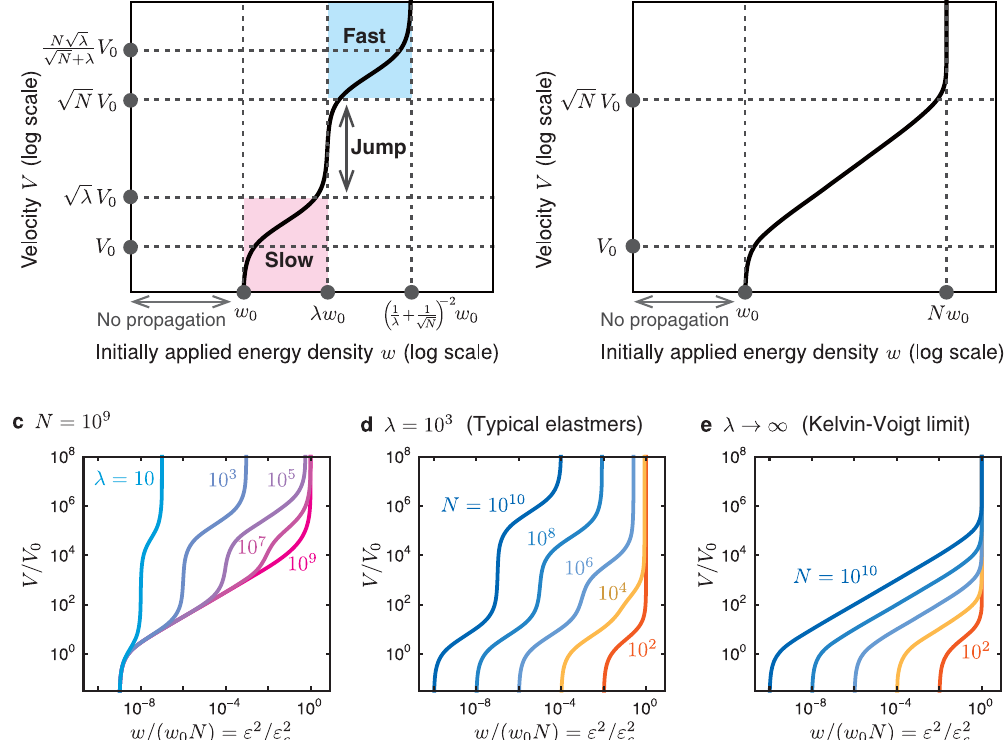
2 2 , obtained from c 0 and 0 0